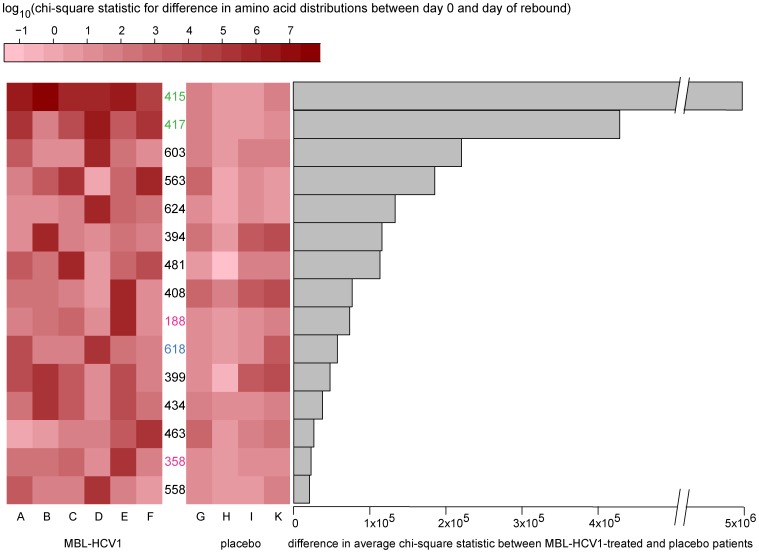
Positions in E1/E2 sequence that show the most significant changes in response to antibody treatment.
Left: Median-shifted chi-square statistic values of the top 15 amino acid positions across E1 and E2 that show the most difference in average chi-square statistic between MBL-HCV1- and placebo-treated subjects. Placebo subject J was unable to be analyzed due to post-rebound viral titers <10,000 IU/ml. The chi-square statistic quantifies changes in amino acid distributions between day 0 and day of rebound for each subject in each position across the genome. A higher statistic represents a larger change in the amino acid distribution (darker red in heatmap). Positions labeled in green are those within the MBL-HCV1 epitope. Positions labeled in blue are known to participate in CD81 binding. Positions in pink belong to the E1 sequence. Right: Differences in mean chi-square statistic between MBL-HCV1-treated and placebo patients. Note that change in position 415 is most significant being 10-fold higher than the second-ranked position 417.